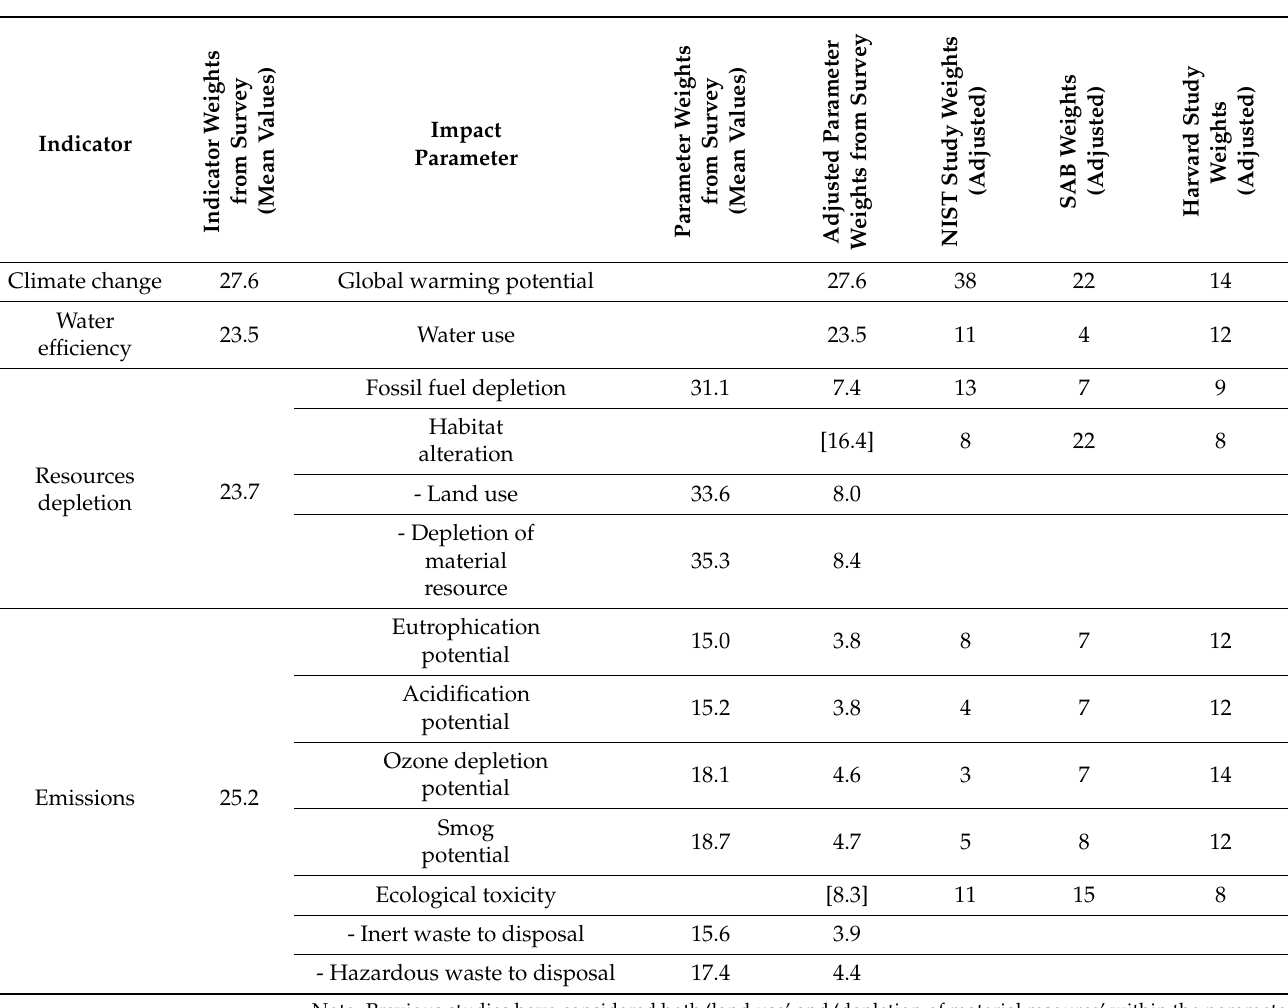
Table 5. Comparison of impact parameter weights from the Survey and previous